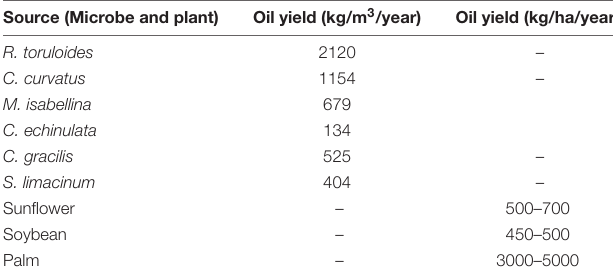
TABLE 5 | Lipid productivity comparison of some selected oleaginous microbes and plants. Microbial oil is generally expressed in kg/m3/year, whereas plant oil productivity is expressed in